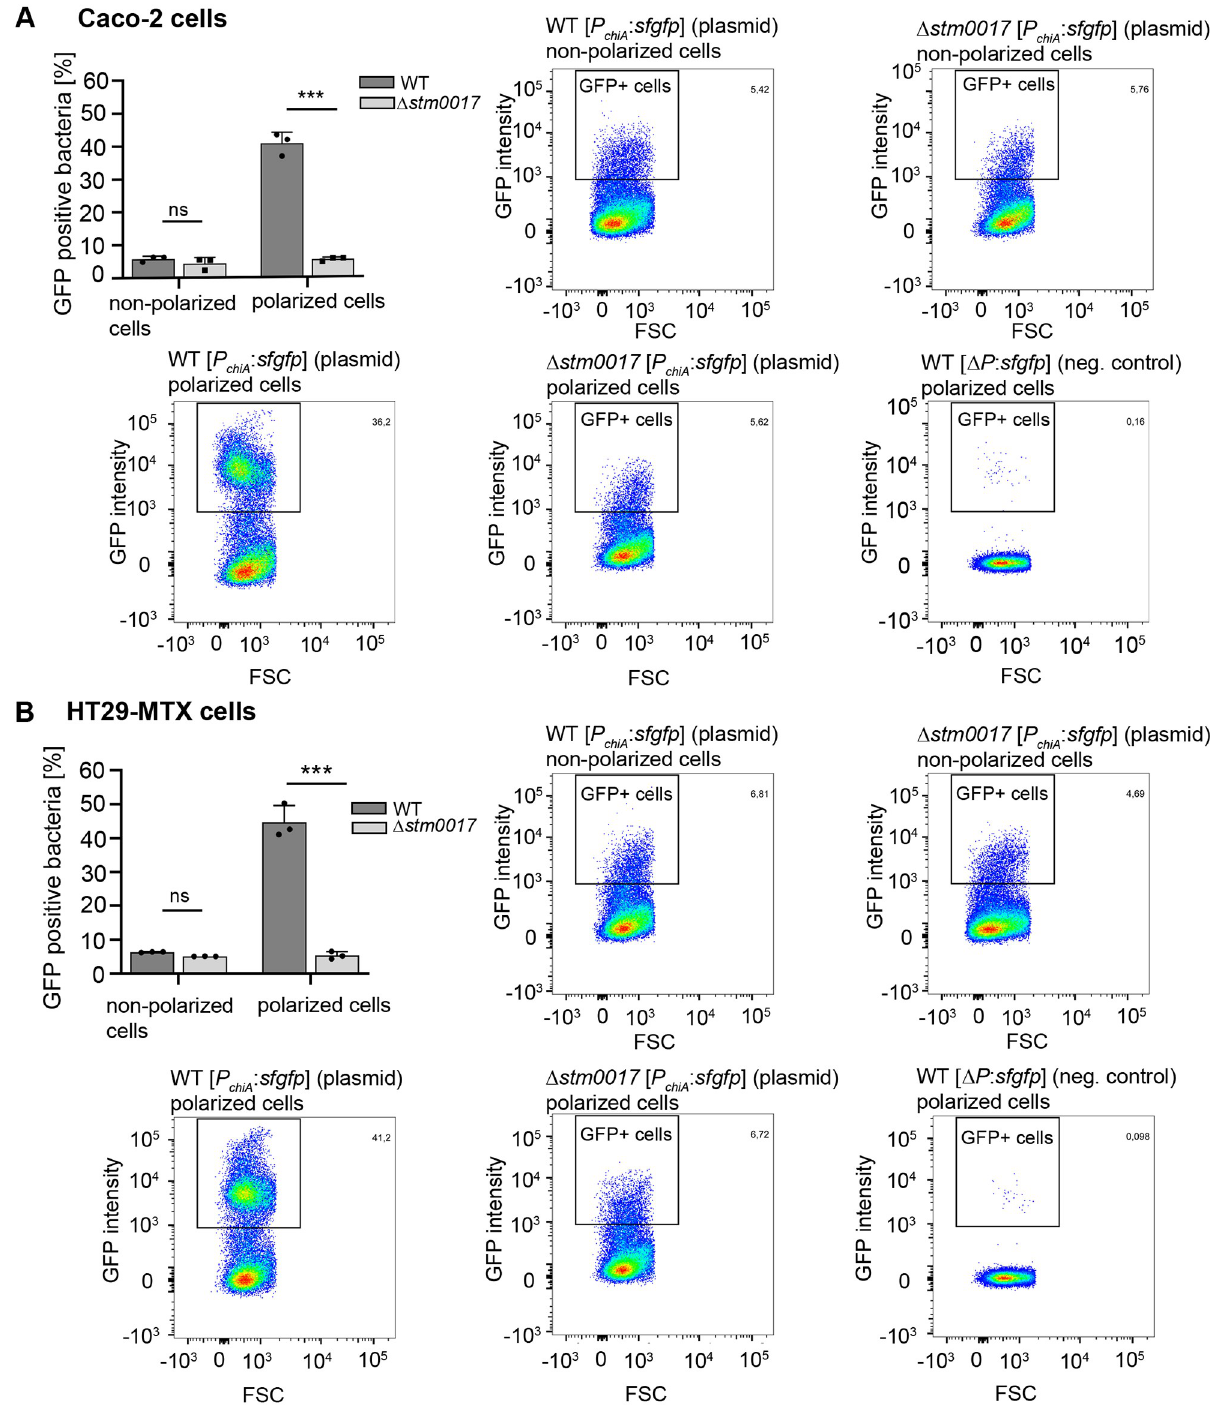
Fig 3. Quantification of chiA expressing S . Typhimurium subpopulations in contact with polarized intestinal epithelial cells. The indicated S . Typhimurium fluorescence reporter strains were incubated for 3 h in contact with polarized and non-polarized Caco-2 (A) or HT-29 MTX cells (B). The bacteria were harvested and analyzed by flow cytometry to quantitate the subpopulations of GFP-expressing bacteria. The dot plots identify the gate that were set to determine GFP positive (GFP+) bacterial cells. The non-GFP expressing S. Typhimurium strain WT Δ P : sfgfp in contact with polarized IEC was used to evaluate background fluorescence. The bar graphs show the average percentages ± standard deviation of GFP positive cells derived from three independent experiments. Statistical analyses were implemented with ordinary one-way ANOVA and Bonferroni´s multiple comparisons test P > 0.05: ns; P � 0.05: * ; P � 0.01: ** ; P � 0.001: *** .